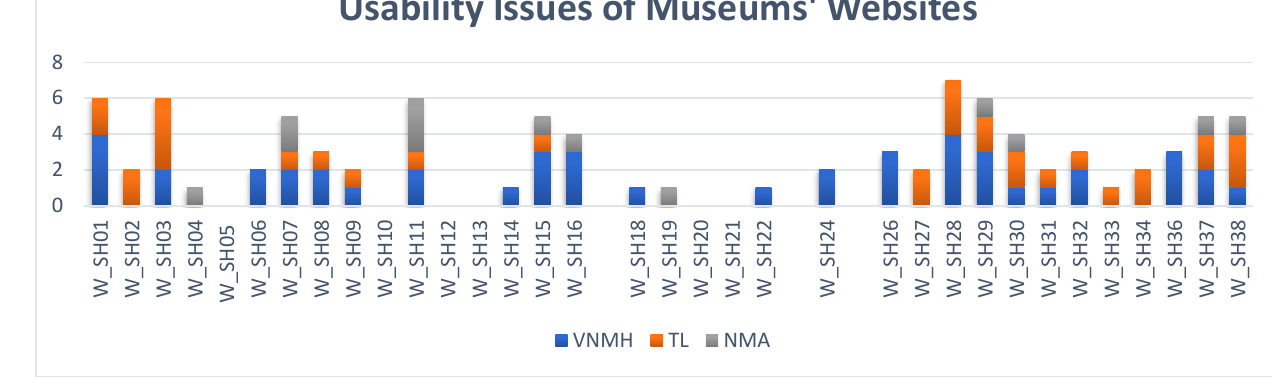
Figure 5. Usability issues of websites of 3 museums surveyed.